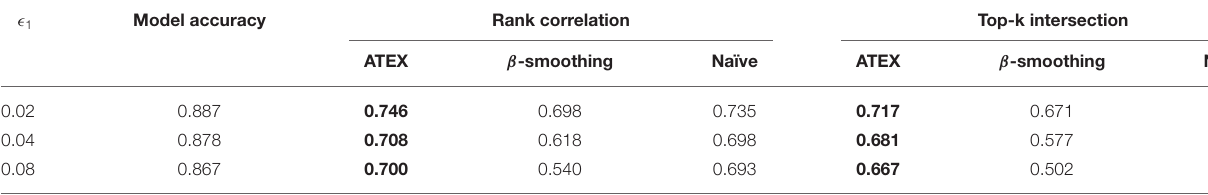
TABLE 2 | Defense against targeted explanation manipulation on FashionMNIST.